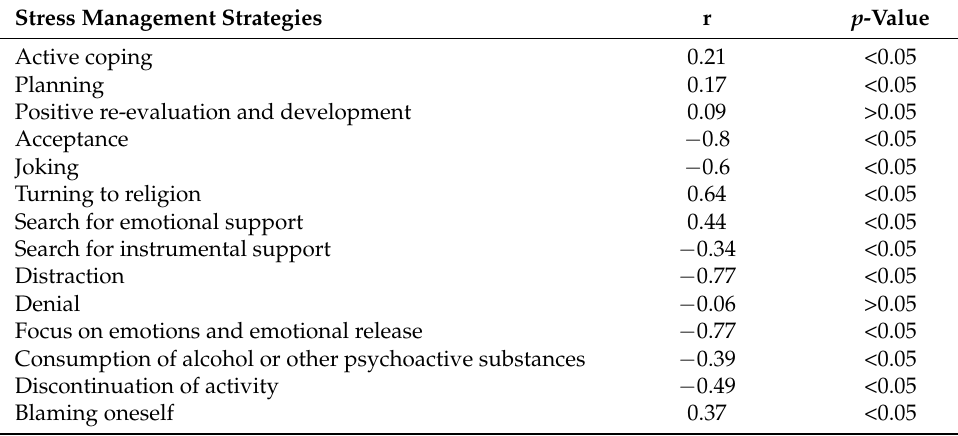
Table 3. Stress management strategies according to age.